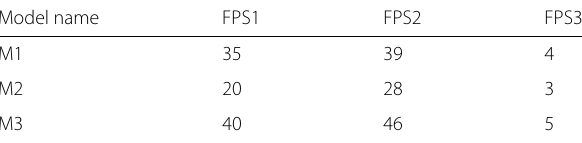
Table 3 FPS of the test